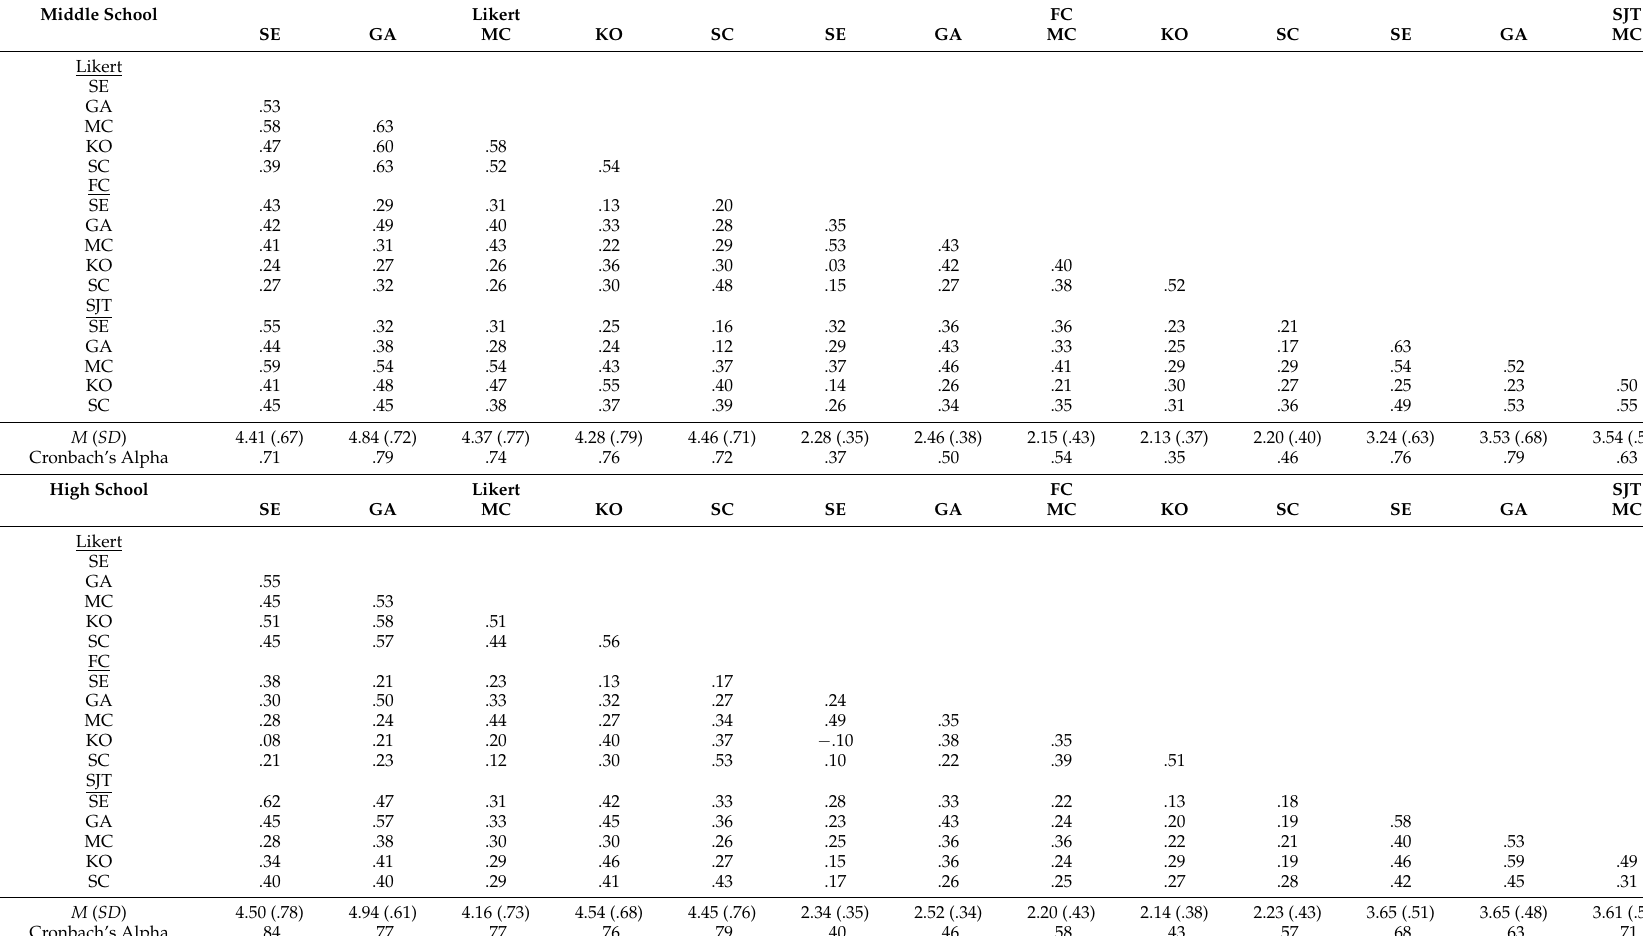
Table 2. Multi-Trait Multi-Method Correlation